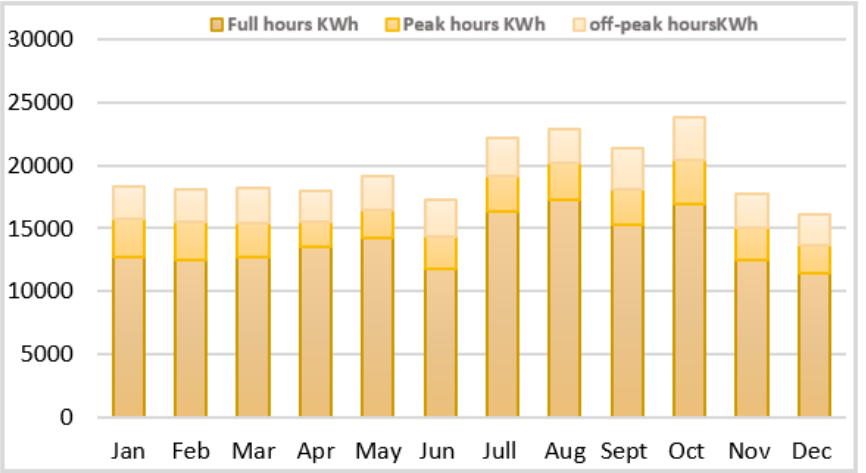
Energies 2022 , 15 , x FOR PEER REVIEW 9 of 27 Figure 4. Monthly electrical load of the factory 2 — Fez 2021. Figure 4. Monthly electrical load of the factory 2—Fez 2021. Figure 4. Monthly electrical load of the factory 2 — Fez 2021.